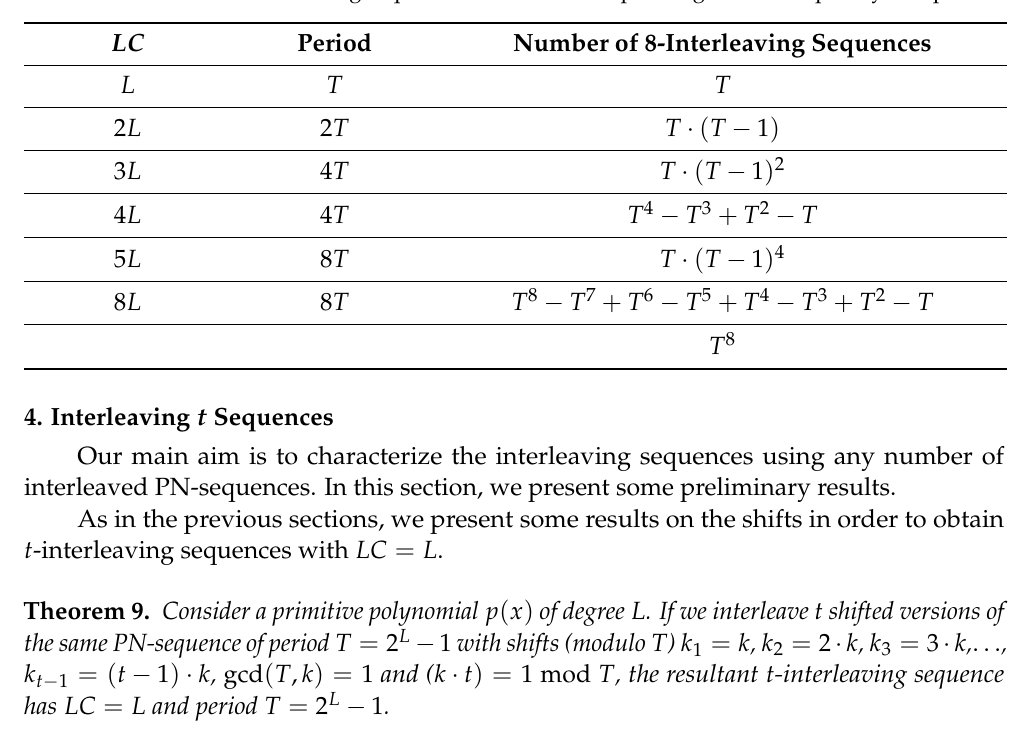
Table 2. Number of 8-interleaving sequences with the corresponding linear complexity and